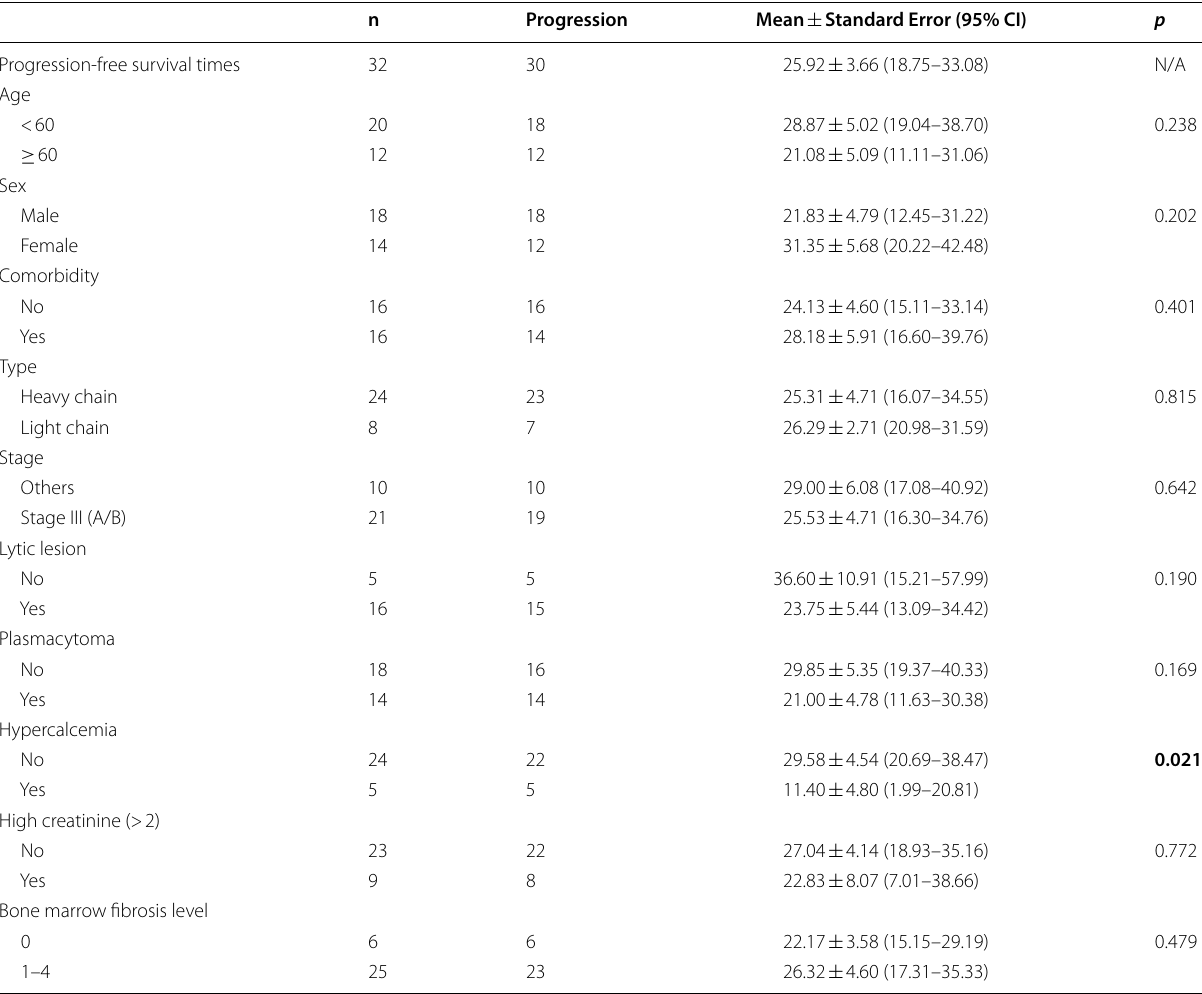
p values marked with bold indicate statistically significant differences between the groups CI, confidence